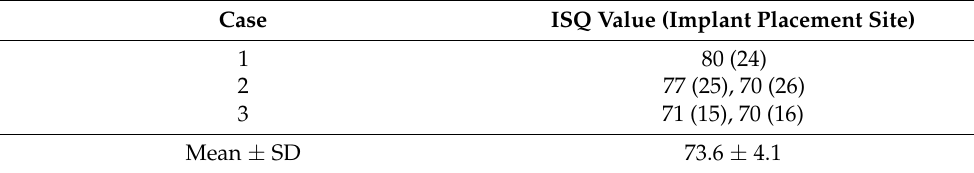
Figure 5. CT findings of pre-operative and post-operative at 6 months are shown: ( a , b ) pre-operative images, sagittal section and coronal section; ( c , d ) post-operative 6 months images, sagittal, and coronal section.